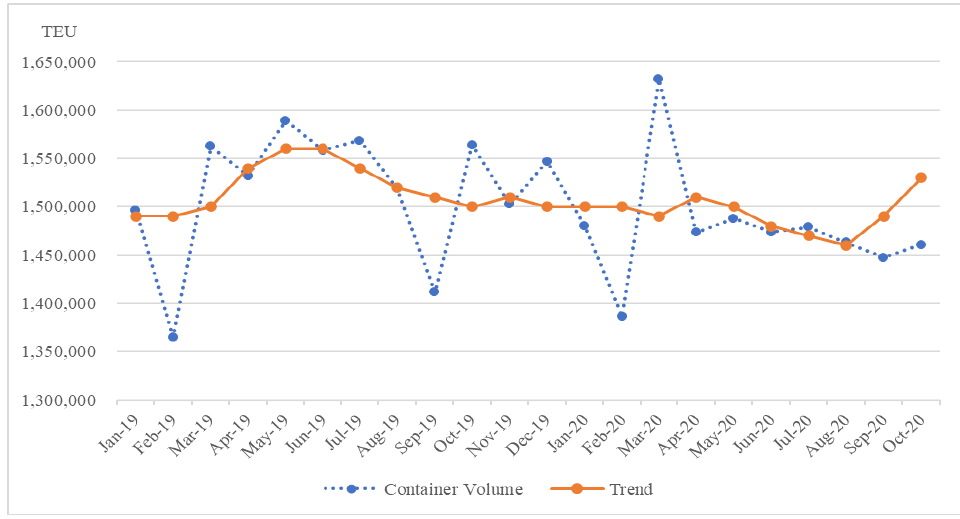
Figure 6. Comparison of container volume and trends for the years 2019–2020 (x: date, y: TEU).